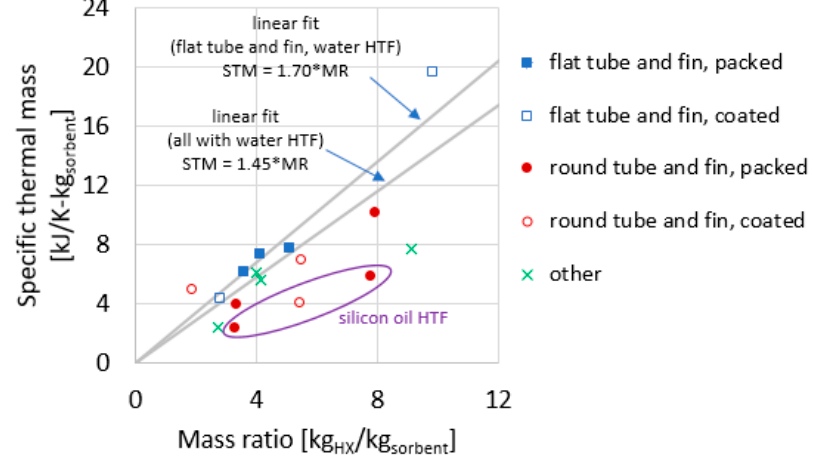
Figure 12. Specific thermal mass plotted against the mass ratio for the heat exchangers reported in this study.